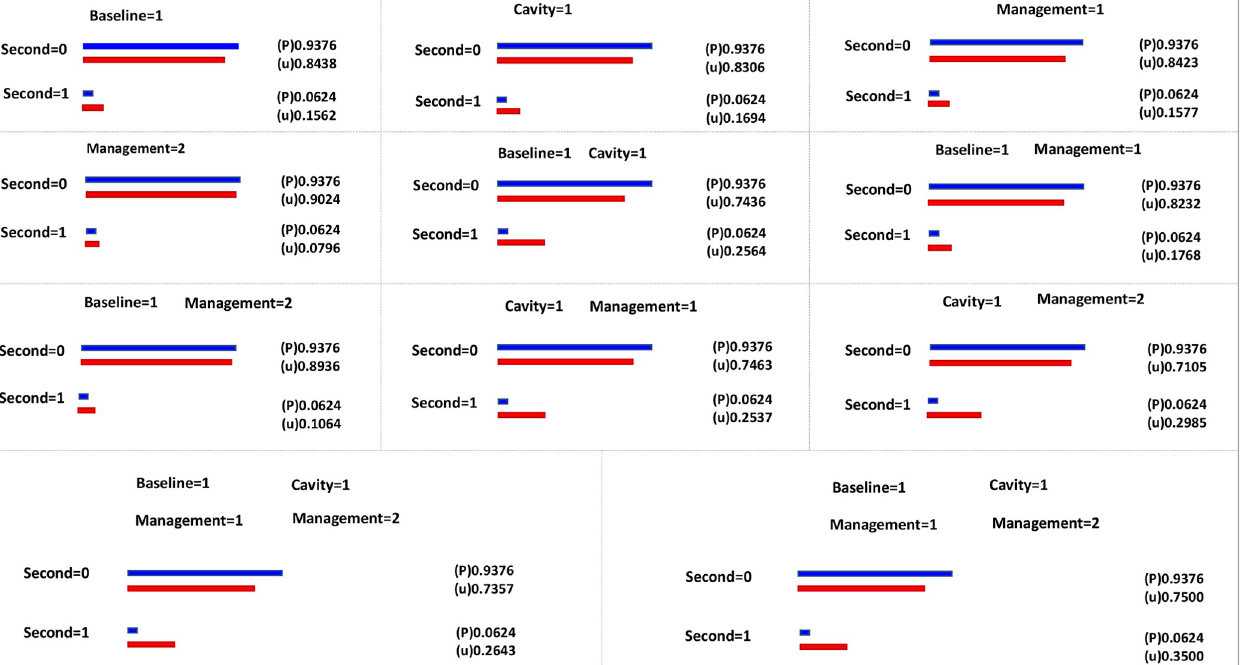
receptor (VDR) gene polymorphisms showed that the VDR gene polymorphisms were associ- ated with rate of sputum culture conversion in MDR TB patients [18]. Research shows that patients with the TT TaqI genotype had significantly longer time to sputum culture conversion compared with Tt genotype (median 46 days for TT genotype vs. 16 days for Tt genotype) [19]. And other report showed that a significantly lower proportion of patients with ApaI aa genotype had converted cultures by 2 months of TB treatment compared to patients with ApaI Aa genotype (26% vs. 51%, P = 0.03) [20]. In addition, it may be that the baseline AFB smear- positive patients are insensitivity to anti-tuberculosis drugs [21]. And two months of treatment can not completely turn most baseline sputum smear positive patients into negative. TB patients with cavities are often more severe and have higher mycobacterial load, initial bacterial load is associated with sputum smear delayed conversion to negative at the end of TB